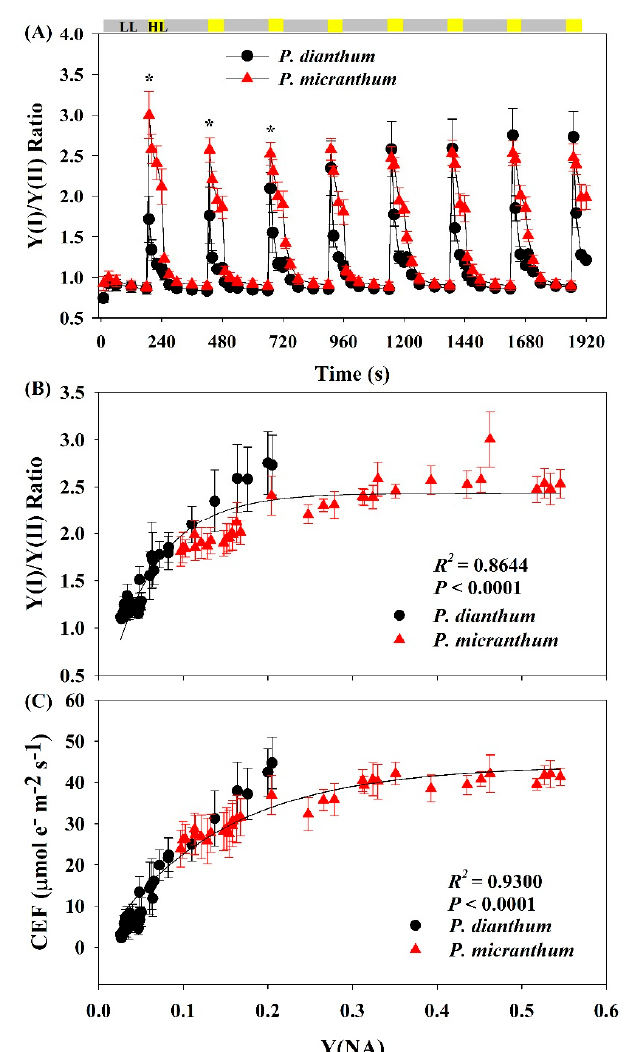
Figure 4. Changes in the Y(I)/Y(II) ratio under fluctuating light alternating between 59 and 1455 µ mol photons m − 2 s − 1 for leaves of Paphiopedilum dianthum and P. micranthum ( A ). Relationship between Y(I)/Y(II) ratio ( B ), CEF ( C ), and Y(NA) after transition from 59 to 1455 µ mol photons m − 2 s − 1 . Y(I), effective quantum yield of PSI; Y(II), effective quantum yield of photosystem II; CEF, cyclic electron flow around PSI. Each bar represents the mean ± SE for five measurements from five individual plants. LL, low light; HL, high light. Asterisks indicate significant differences between P. dianthum and P. micranthum with the t-tests of independent